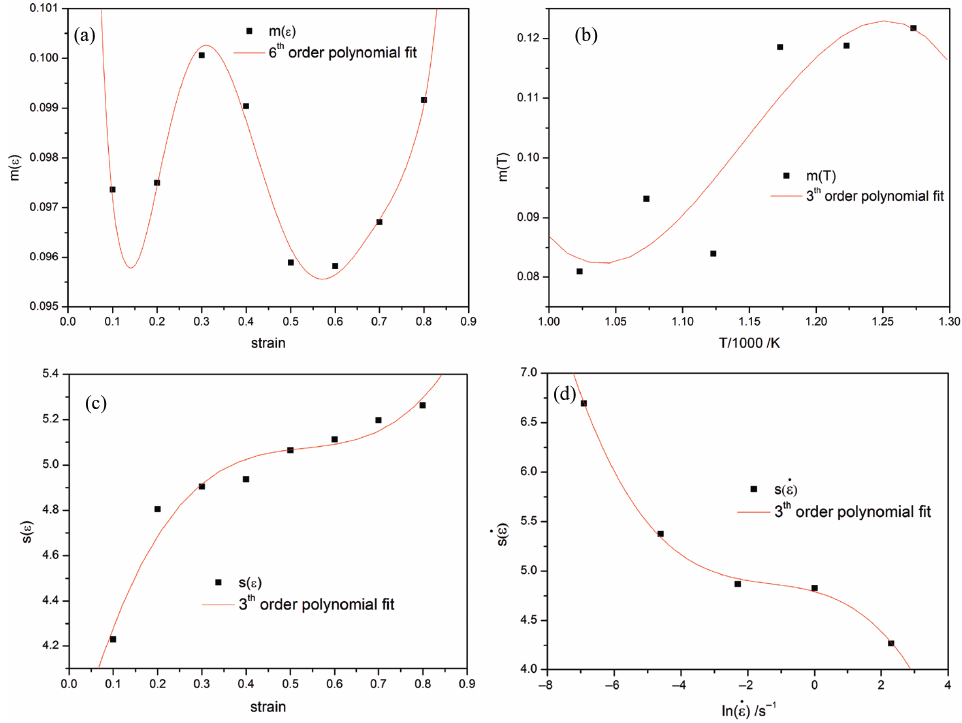
Figure 12: m, s changing with strain, strain rate and temperature: (a) m ( ε ); (b) m ( T ); (c) s ( ε ); (d) s ( _ ε ).